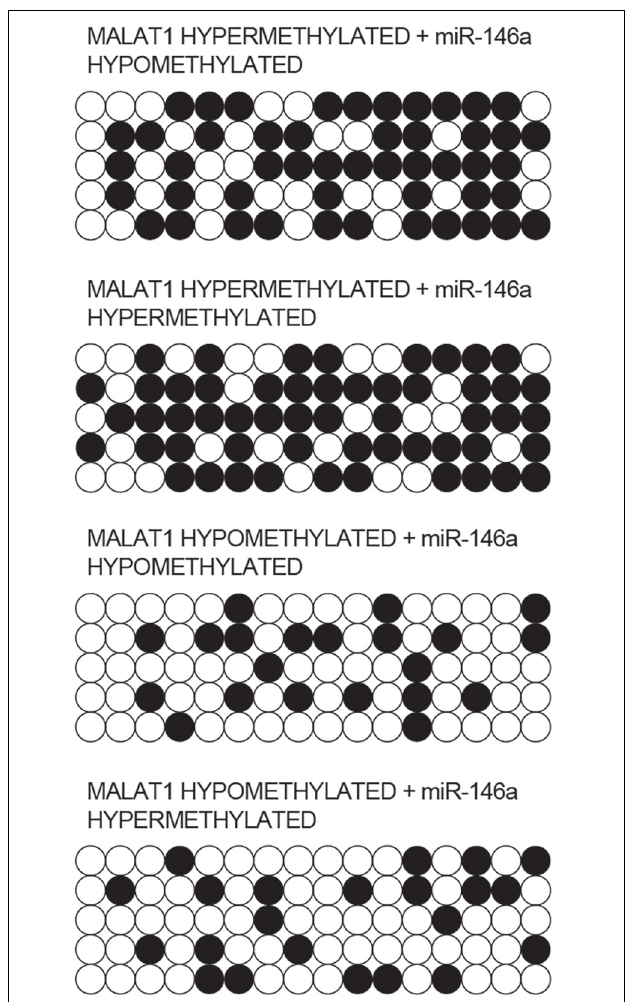
FIGURE 4 | Bisulfite sequencing indicated that the promoter methylation of MALAT1 was comparable between the MALAT1 HYPER + miR-146a HYPO group and the MALAT1 HYPER + miR-146a HYPER group, as well as between the MALAT1 HYPO + miR-146a HYPO group and the MALAT1 HYPO + miR-146a HYPER